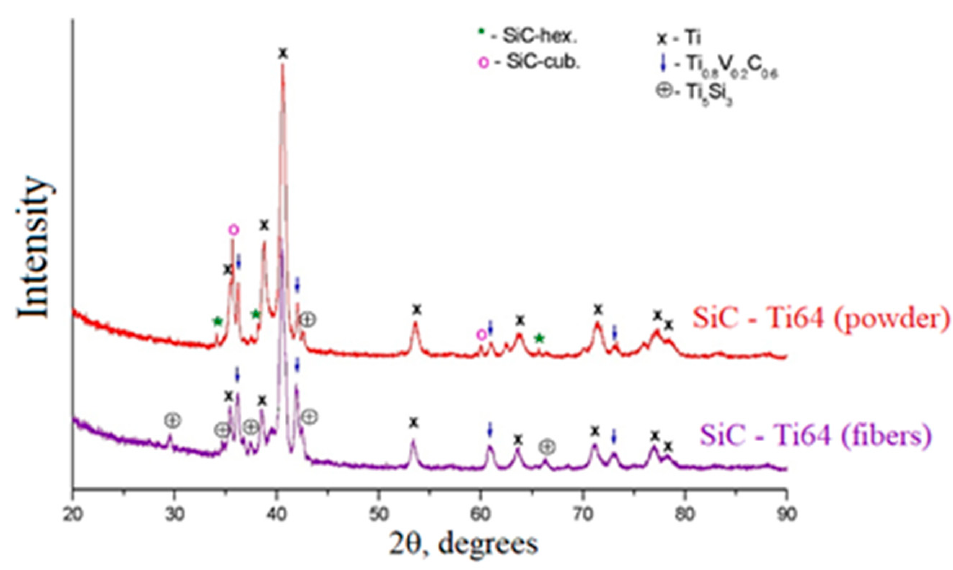
Figure 4. X-ray diffraction patterns of Ti64-SiC powder and Ti64-crushed fiber SiC samples.